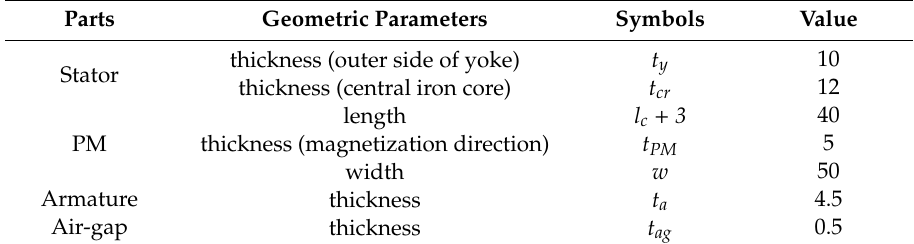
Table 2. Selected geometric parameters of voice coil motor (unit: mm).